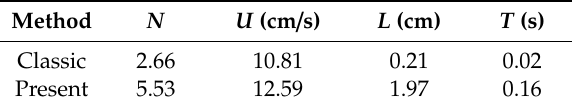
Table 2. Results of different algorithms.